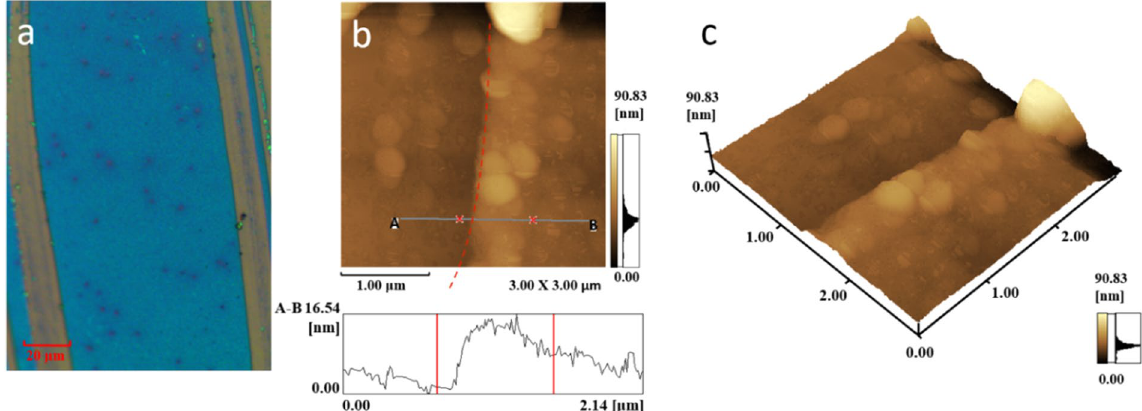
Figure 1. Large area, few-layer In 2 Te 3 films by CVD. Optical image ( a ) and AFM images ( b , c ). The height profile in ( b ) shows a thickness of 6.6